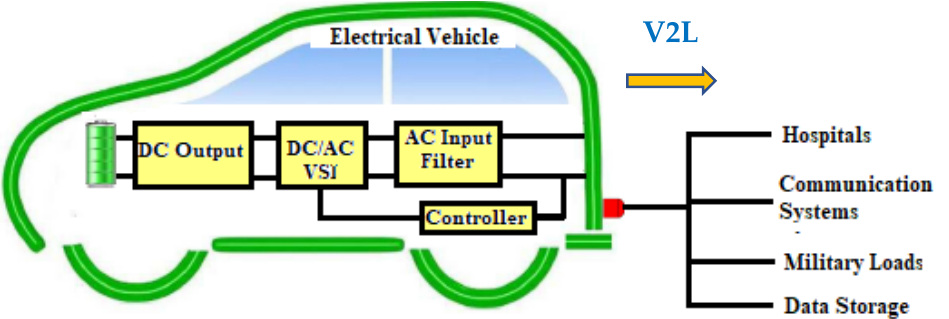
Figure 1. Schematic of the V2L operation of the system.